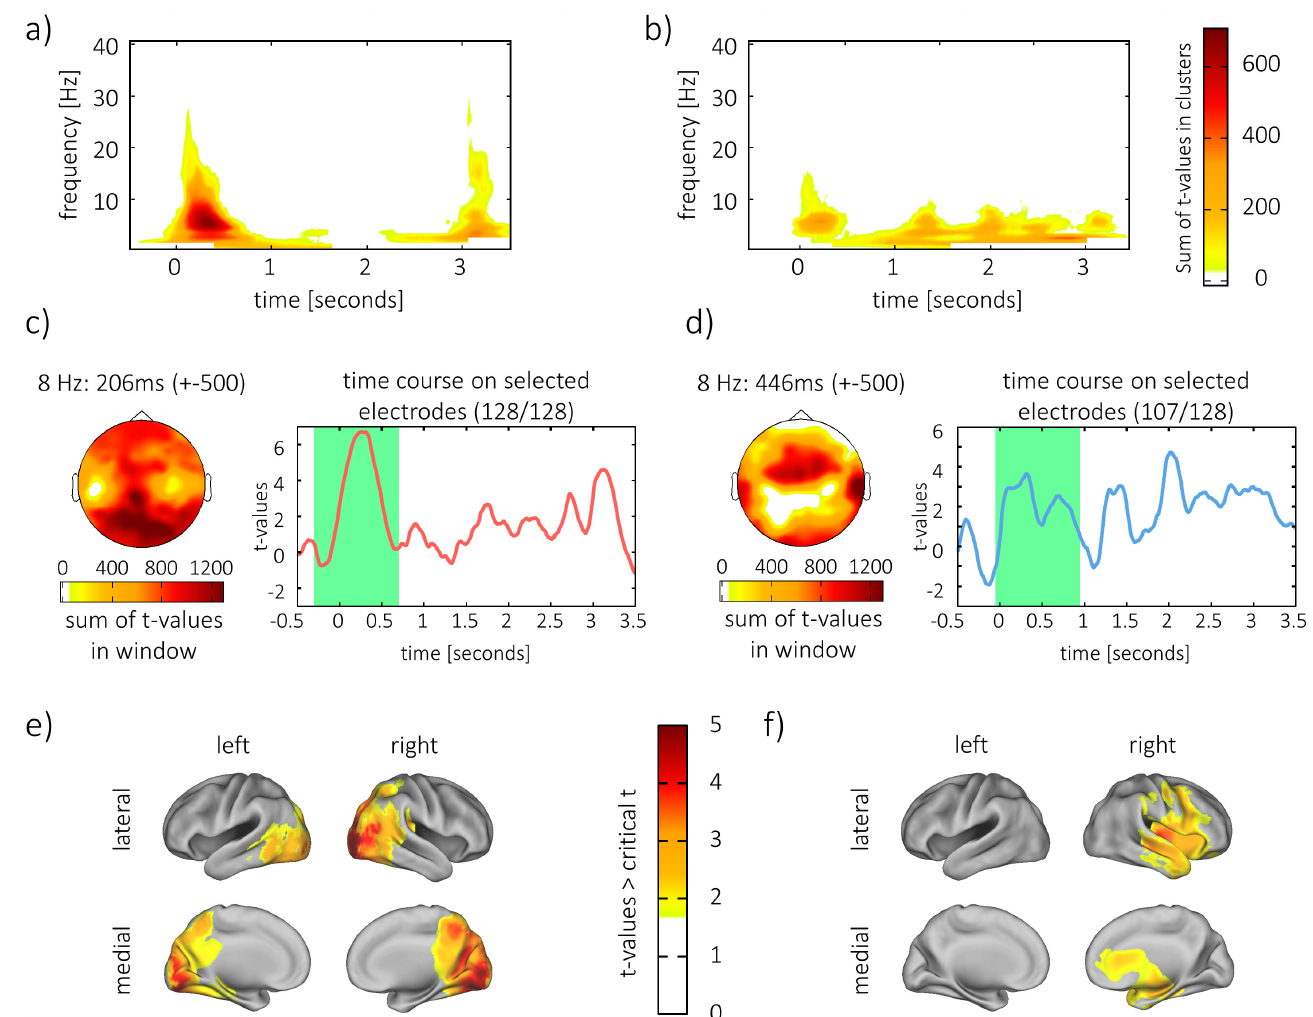
Fig 4. Content specificity of phase during encoding. Broad clusters of difference in phase similarity across time. Frequency and electrodes were observed (a) in the visual condition and (b) in the auditory condition. t-values were summed across electrodes in the cluster to display the results. (c,d) Topography of 8 Hz content specificity and time course of differentiation (c) in the visual condition and (d) in the auditory condition. The time course (c, d right) is the t-statistic of averaged content specificity, across all electrodes that are included in the strongest cluster. The green window marks the time window of 1 s around the center of the strongest cluster. (e) Source reconstruction of content specificity in the visual condition and (f) in the auditory condition. For consistency, sources were tested and plotted on the averaged similarity across the encoding time window of 1 s around the peak of the strongest cluster (green window). Likewise, topographies (c,d left) show summed t-values on the scalp of content specificity across this time window.